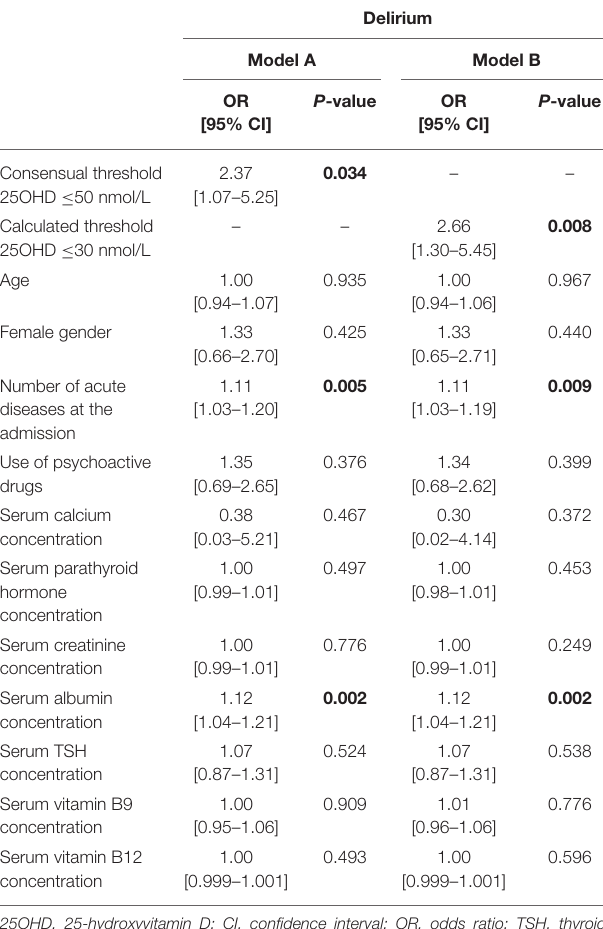
TABLE 2 | Univariate and multiple logistic regression models assessing the cross-sectional association between serum 25-hydroxyvitamin D concentration (independent variable) and the diagnosis of delirium (dependent variable) after adjustment for potential confounders* ( n = 240).